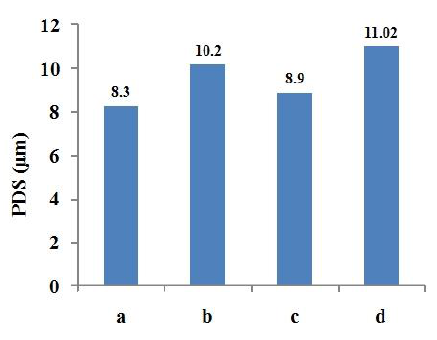
Figure 20. PDS of each processing condition.